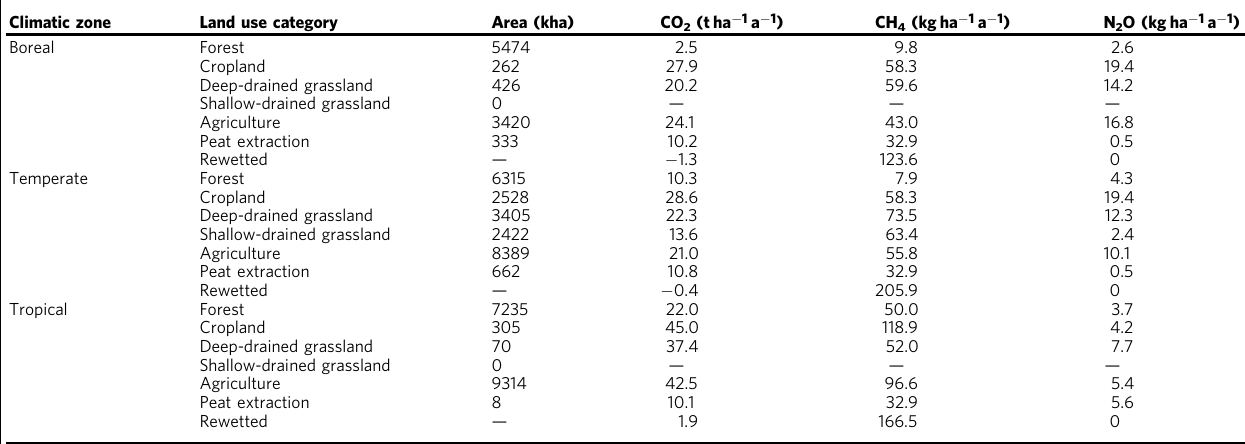
Emission factors assumed for rewetted peatlands are also shown for each climatic zone.